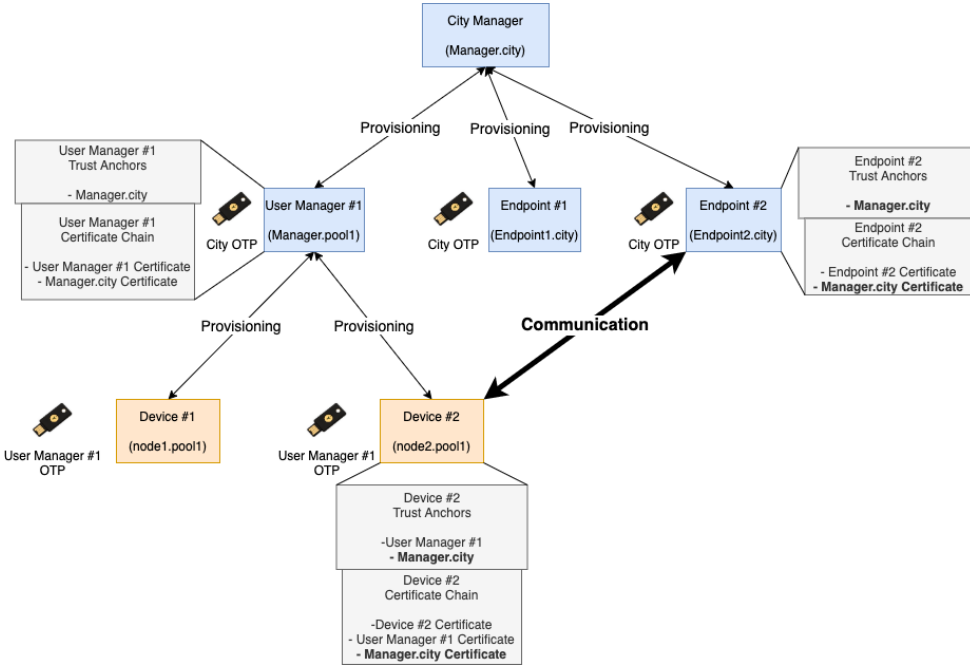
Figure 9. Smart cities use